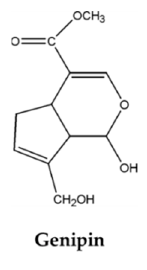
Figure 20. The structure of genipin.